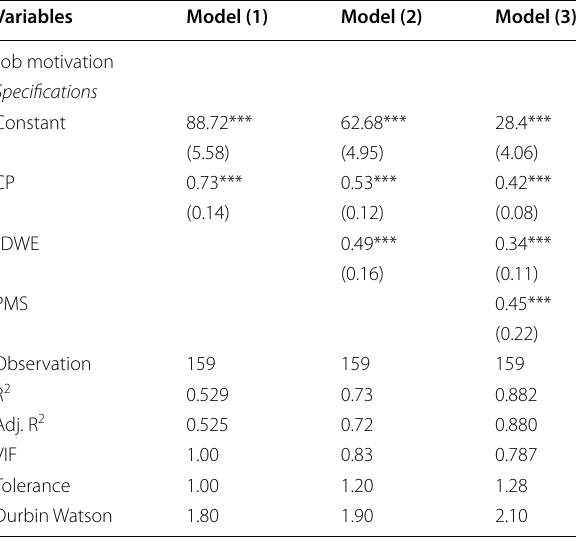
Table 3 The causal effect of intrinsic and extrinsic factors on teachers’ motivation